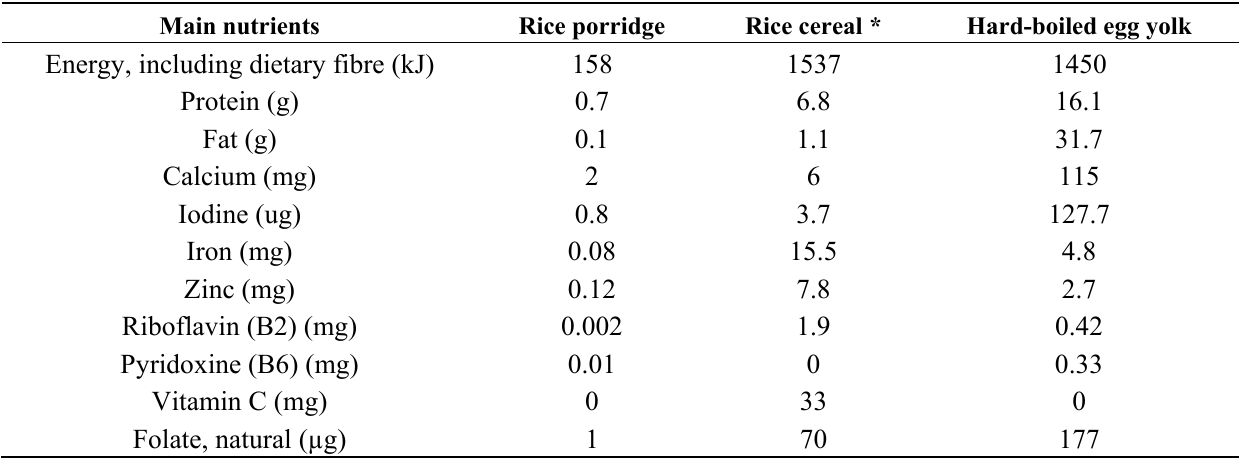
Table 5. Nutritional composition of rice porridge, rice cereal and egg yolk (value per 100 g).